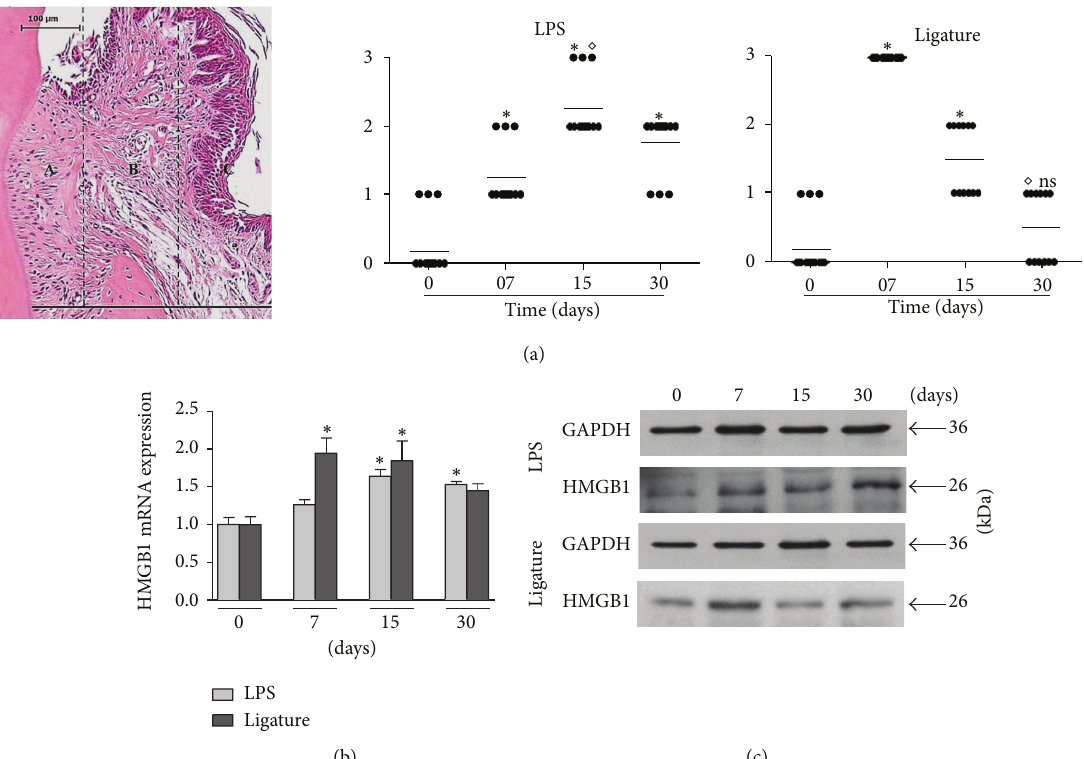
Figure 2: (a) Stereometric analysis of the inflammatory cells. Representative histologic section shows the 3 areas used for analysis. Graphs show average ± standard deviation of scores obtained in the LPS- and ligature-induced periodontal disease models. The LPS model is associated with a sustained inflammatory reaction, while the ligature model presented higher density of cellular infiltrate at 7 days and a decrease on the severity of inflammation at 30 days. (b) and (c) HMGB1 mRNA and protein expression assessed by qPCR (b) and Western blot (c) during the course of LPS- and ligature-induced periodontal disease. ∗ Significant difference compared to control ( 𝑃 < 0.05